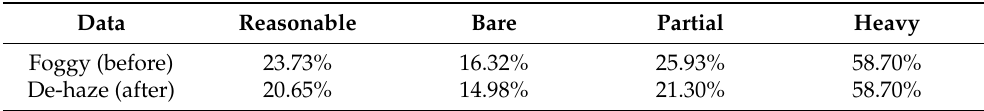
Table 5. Log-average miss rate over false positive per image (FPPI) results for ACSP pedestrian detector using Foggy